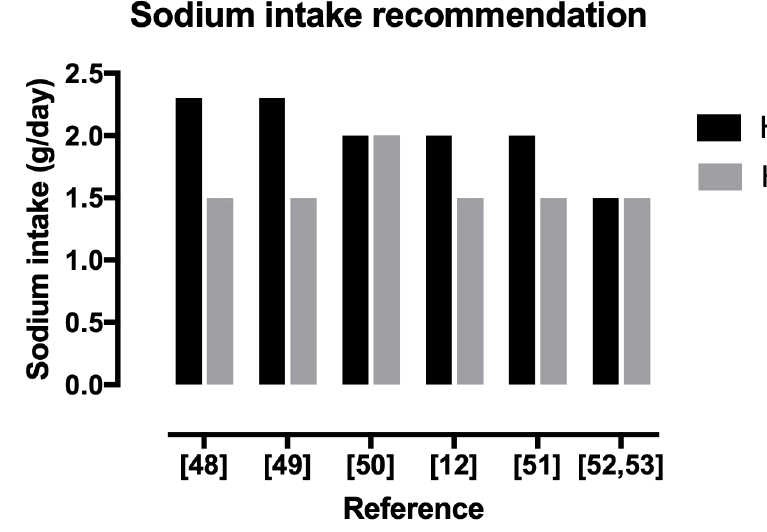
Figure 1. Recommendations of sodium intake